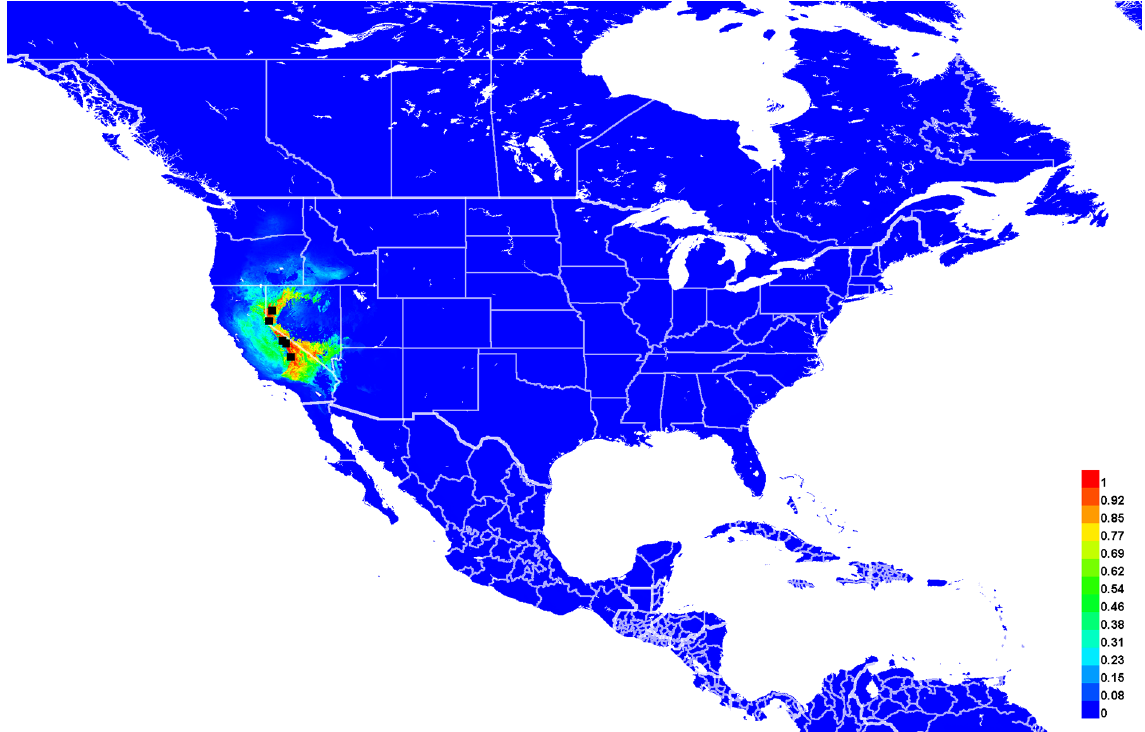
Fig. 45. Georeferenced collection records of Lasioglossum ( D. ) imbriumbrae sp. nov. (black squares) and predicted distribution by maximum entropy ecological niche modeling in Maxent (colour shading). Warmer colours indicate higher cloglog probability of